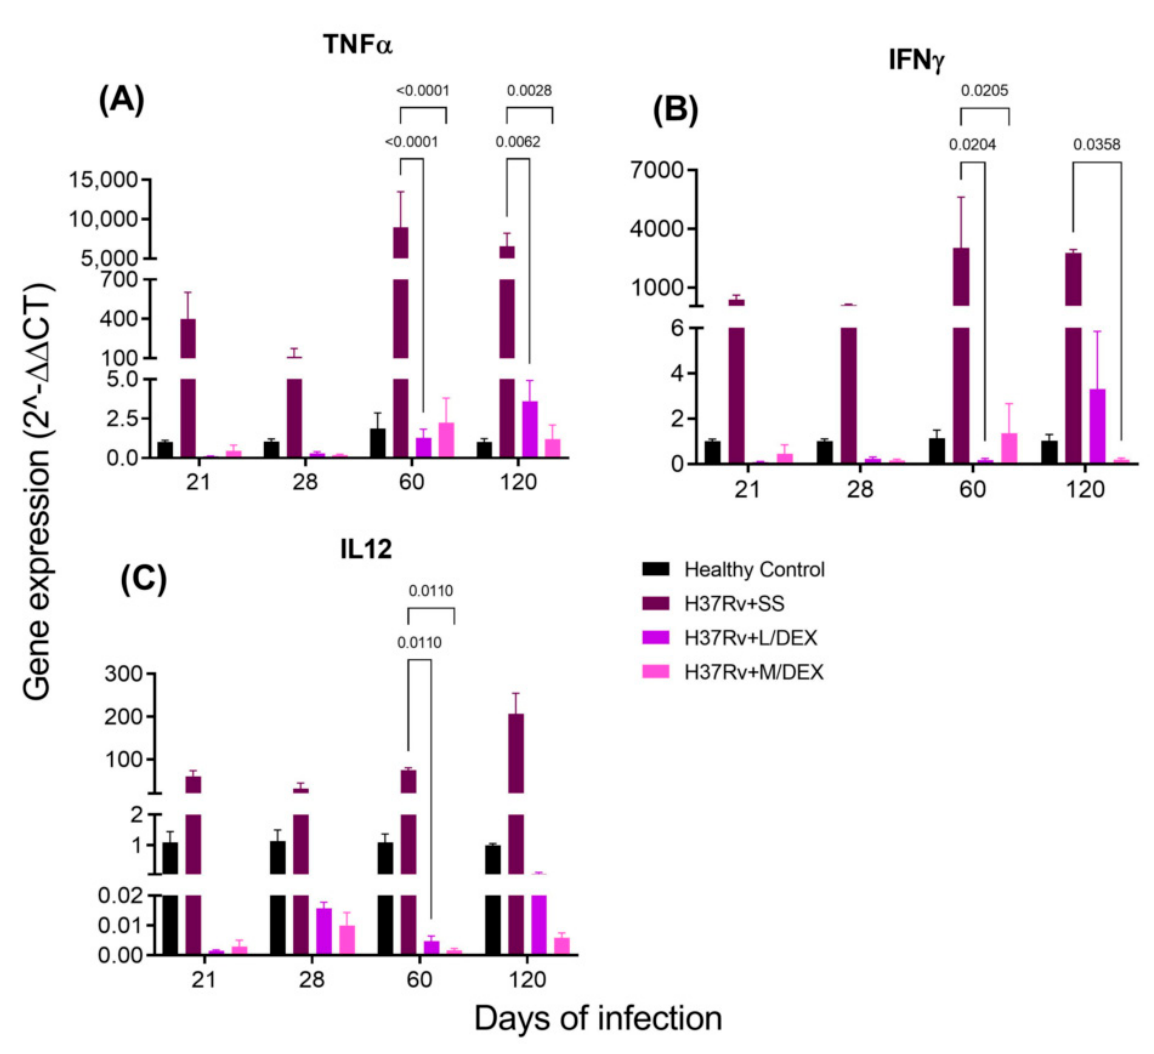
Figure 6. Effect of IN L/DEX (0.05 mg/kg BW) and M/DEX (0.25 mg/kg BW) on pro-inflammatory cytokines of the hippocampus of mice infected with Mtb H37Rv. ( A ) TNF α . F (3, 8) = 7.546, p = 0.0102. Mixed-effects model (REML). Dunnett’s multiple comparisons test. ( B ) IFN γ . F (3, 8) = 3.701, p = 0.0617. REML. Tukey’s multiple comparisons test ( C ) IL-12. F (3, 8) = 76.07. REML. Dunnett’s multiple comparisons test. There is a significant increase in gene expression in the absence of any detectable brain infection since day 21 post-infection. The treatment with L/DEX and M/DEX doses reduced the expression of these pro-inflammatory cytokines. RNA was isolated from hippocampus homogenates and reverse-transcribed to cDNA, then analyzed for gene expression changes of the indicated cytokine. Fold-change values were normalized to expression levels of the healthy controls ( n =